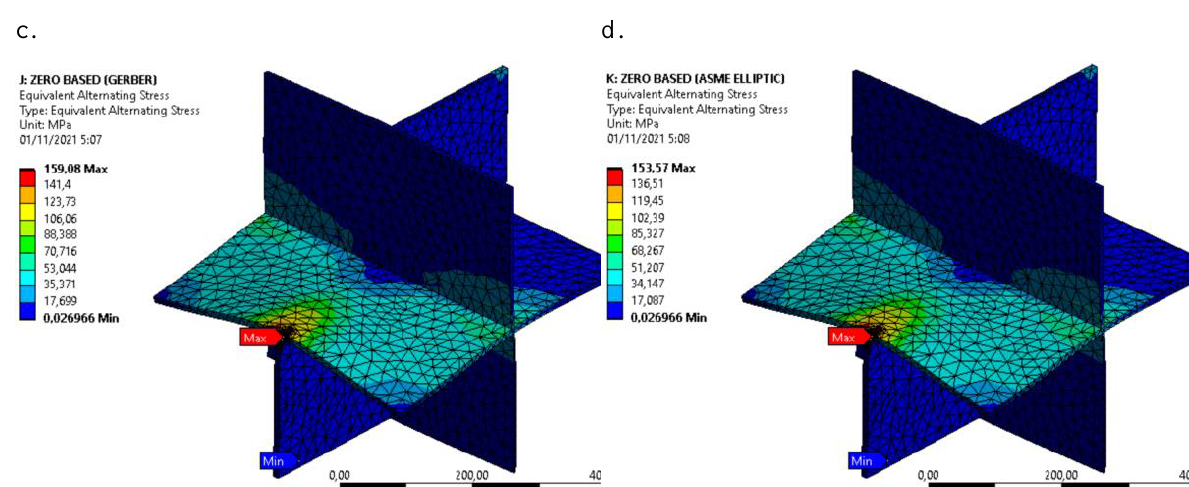
Figure 24: Alternating stress using different mean stress correction theories: a. Goodman; b. Soderberg; c. Gerber; d. ASME elliptic